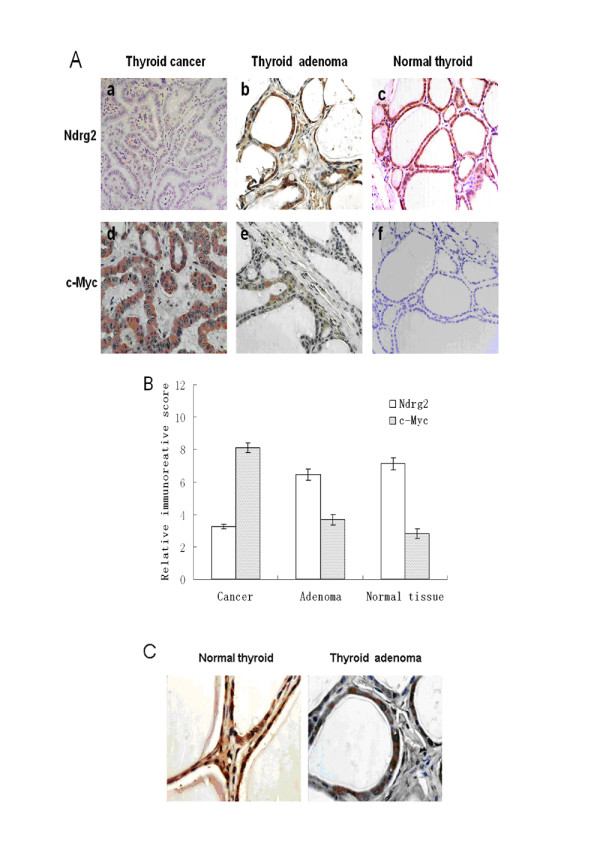
Differential expression of Ndrg2 and c-Myc in thyroid carcinoma, adenoma and normal tissue. (A) Immunohistochemical analysis of Ndrg2 and c-Myc in thyroid cancer, adenoma and normal tissues. (B) Ndrg2 expression was higher in normal tissue than the carcinomas (p < 0.05). The amplification of c-Myc was more abundant in cancers than in normal thyroid tissue. (C) Analysis of Ndrg2 localization in thyroid cells. The brown immunostaining indicates the cytoplasmic localization of Ndrg2.